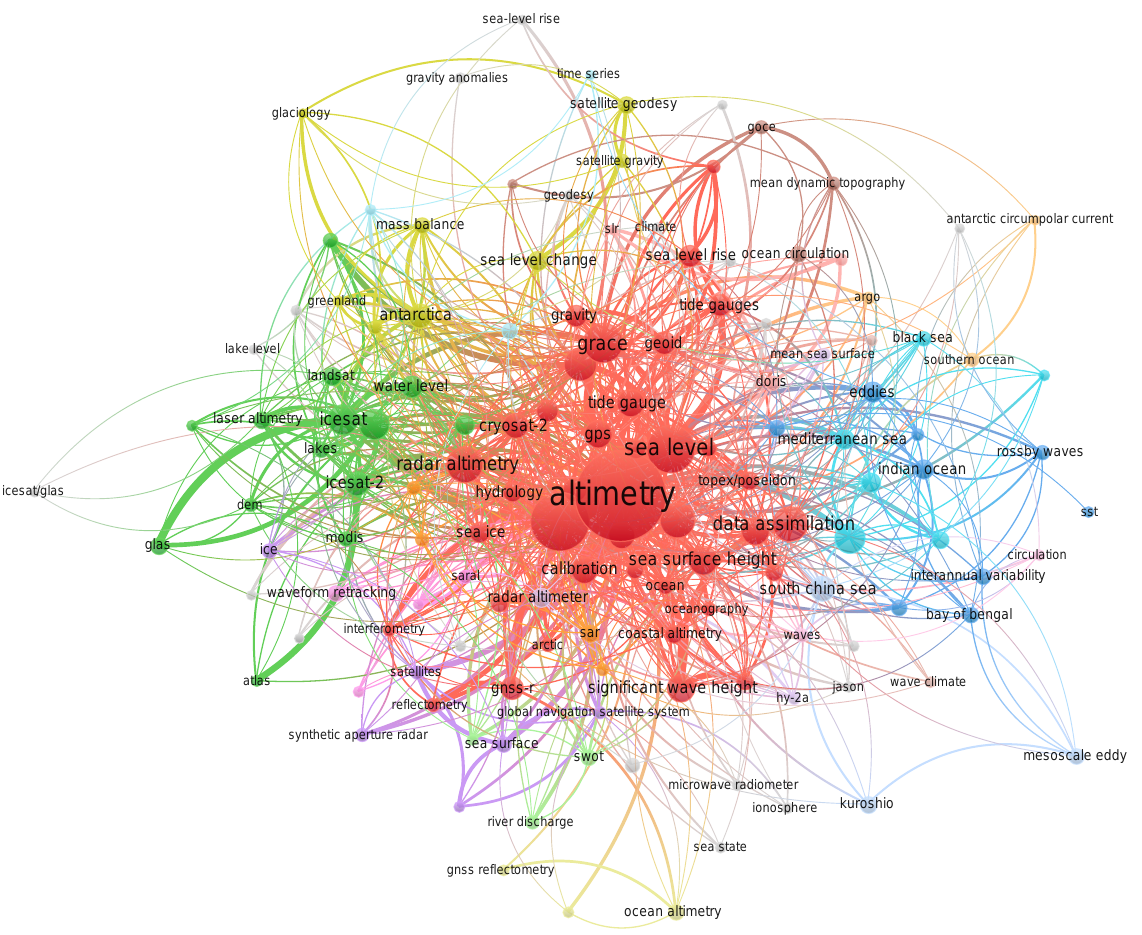
Figure 10. The keywords’ co-occurrence network. To make the figure more readable, we set the limit connections threshold as 20 and presented 140 essential